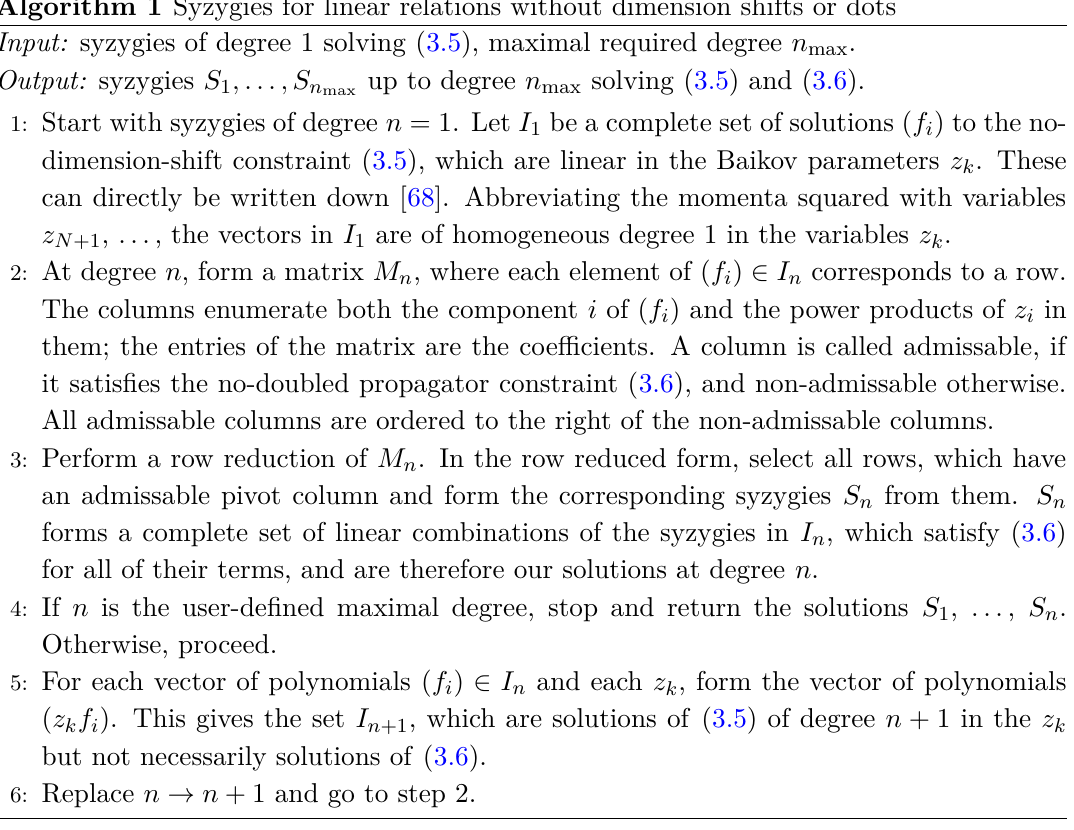
Algorithm 1 Syzygies for linear relations without dimension shifts or